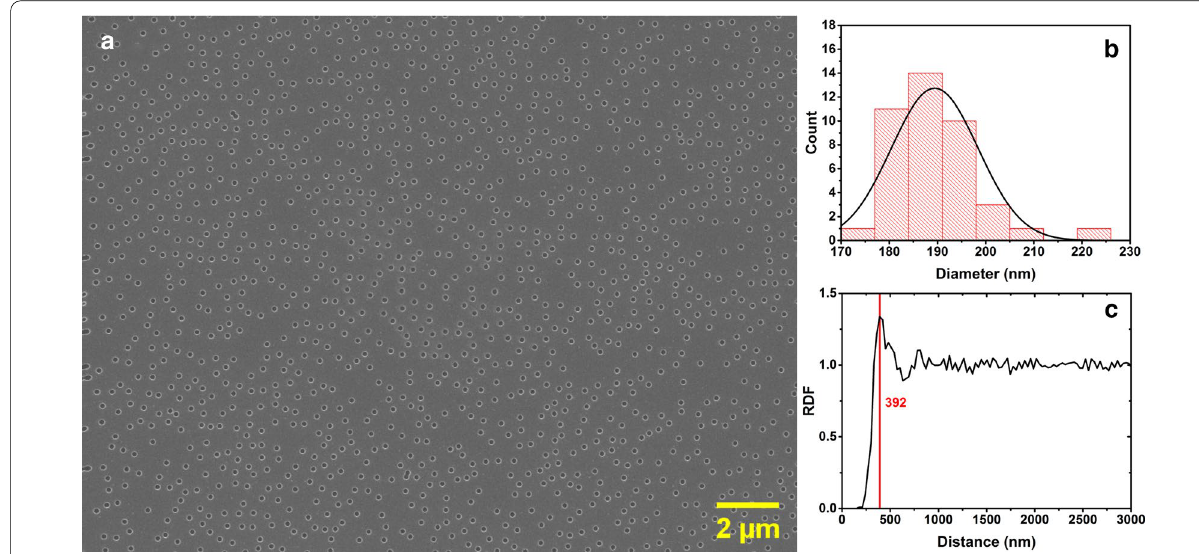
Fig. 4 a SEM image of a CL-patterned resist layer using 140-nm-diameter PS-NBs on a ZnO NP-seeded Si substrate, after RIE etching and Al wet etching. b Distribution of the diameter of the etched nanoholes in the resist layer. c The radial distribution function of the patterned nanoholes, with an average nanohole neighboring separation of 392